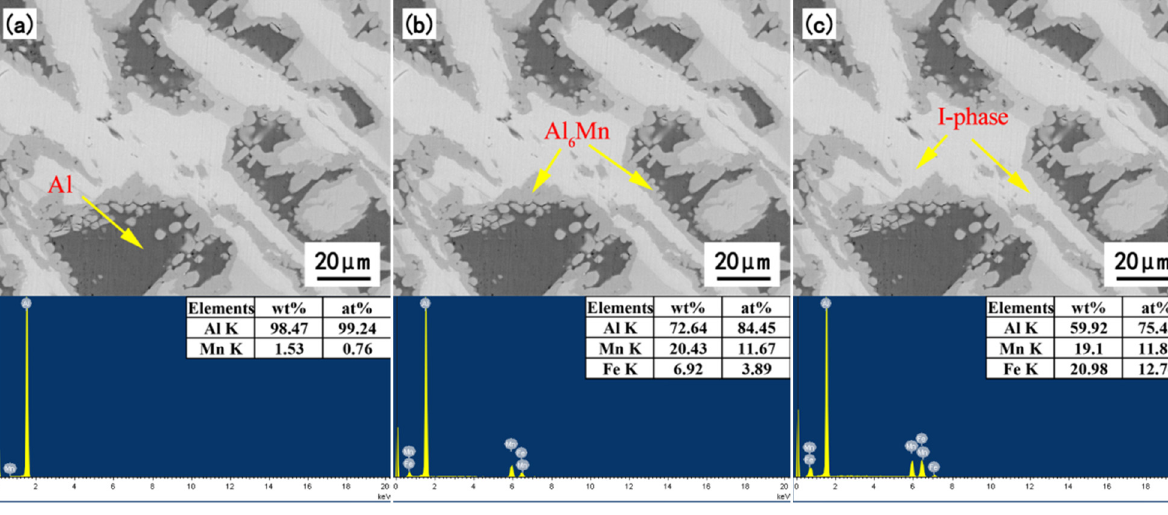
Figure 7: Scanning morphology of Al – Mn – Fe cast alloy at high magni fi cation and